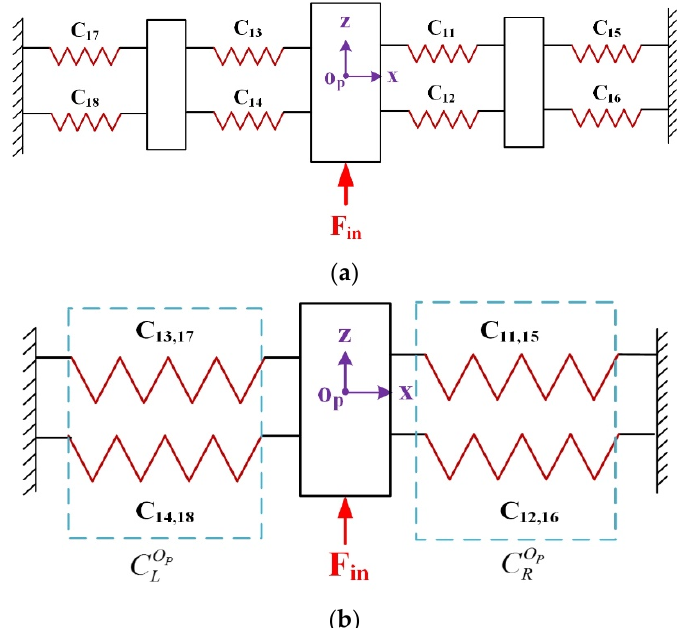
Figure 8. Schematic of the module VI.